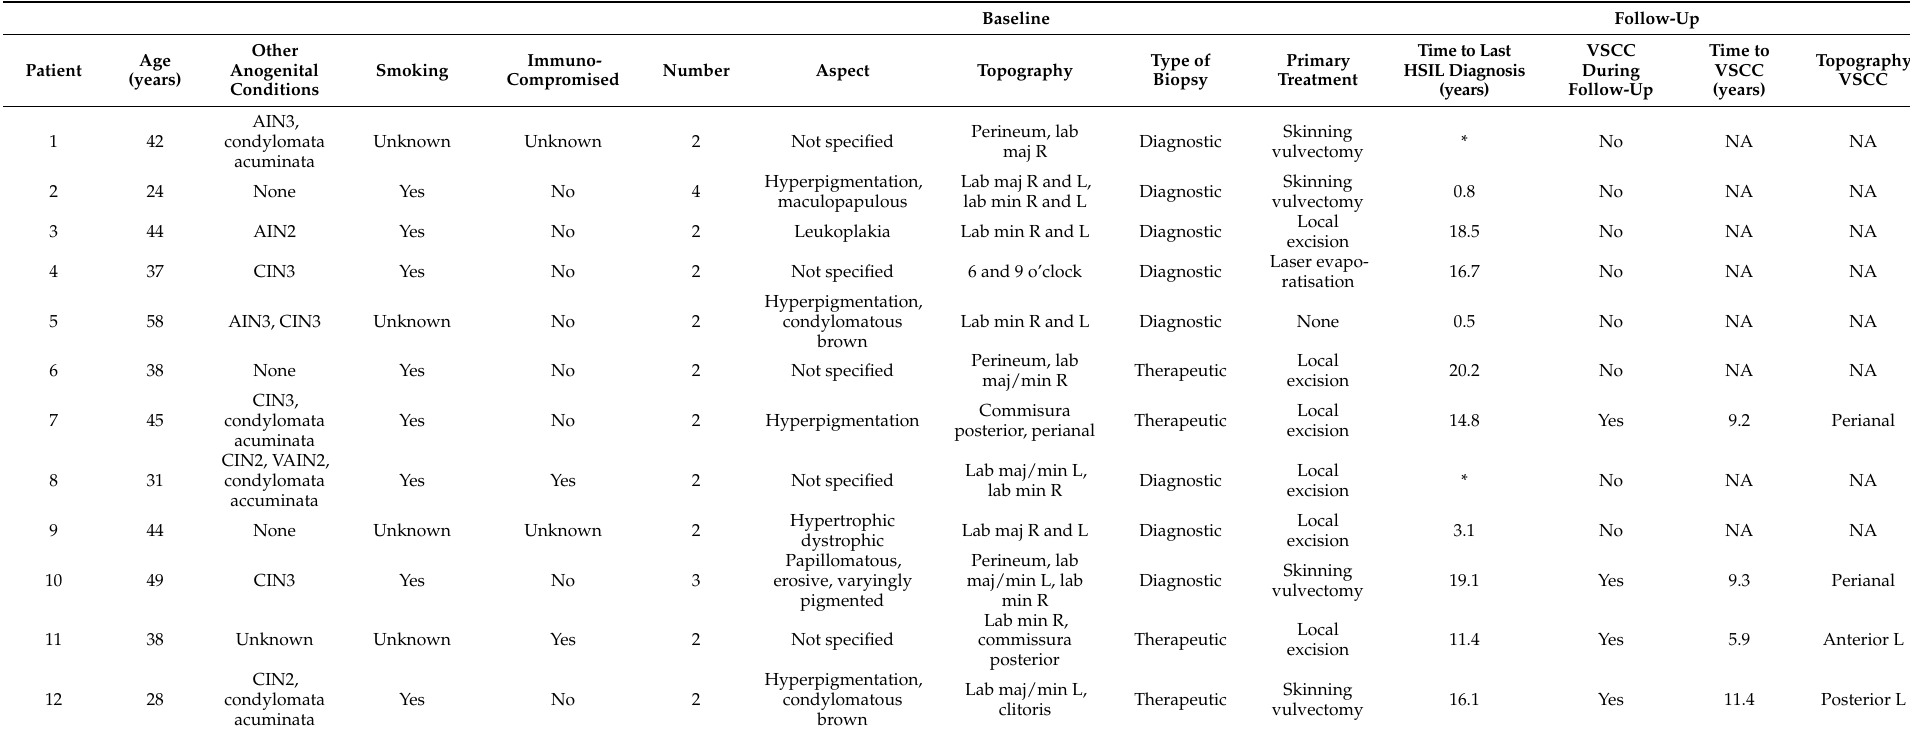
Table 1. Baseline and follow-up characteristics of the study population of 12 patients with multifocal